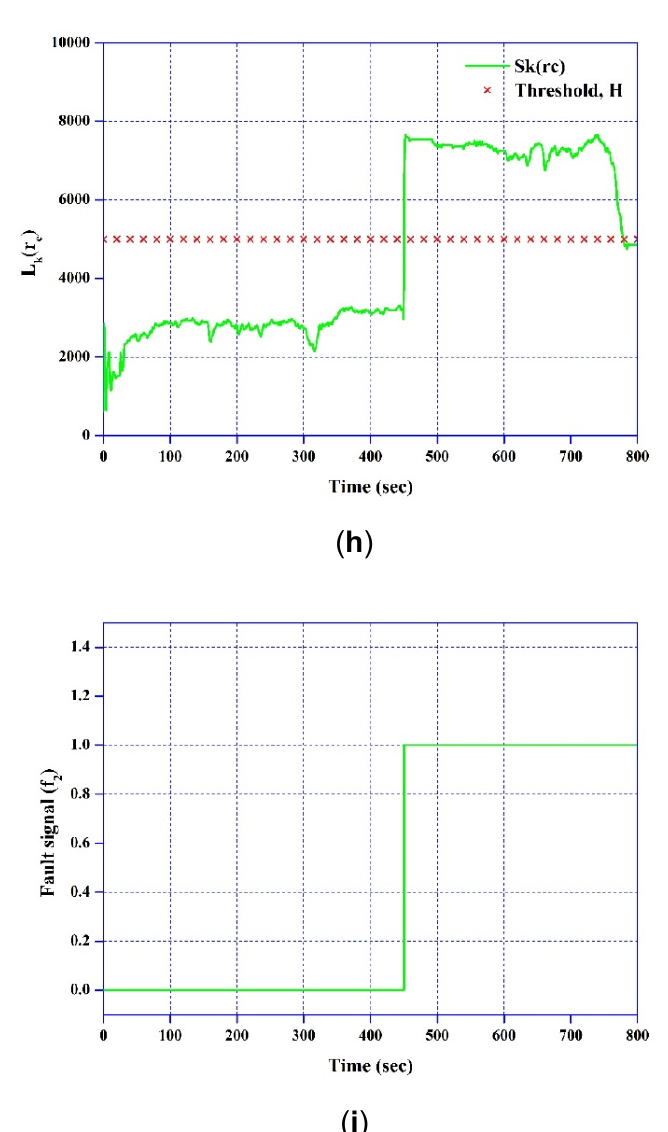
Figure 9. Sensor measurements, residuals, and detection results in coolant inlet scaling fault of HWFET driving cycle (( a )—Stack temperature values, ( b )—Coolant inlet temperature value, ( c )—Water pump motor speed, ( d )—Radiator fan motor speed ( e )—Residual from stack sensor, ( f )—Residual from coolant inlet temperature, ( g )—CUSUM result from stack temperature sensor, ( h )—CUSUM result from coolant inlet temperature sensor, ( i )—Isolated temperature sensor fault f 2 signal).